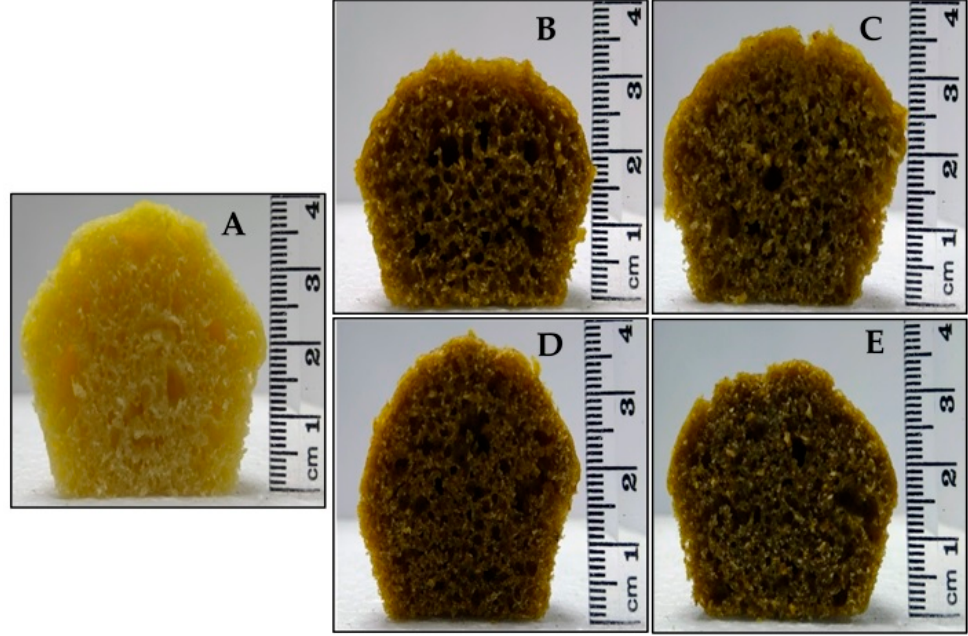
Figure 2. Muffin color and crumb structure images ( A ): control, ( B ): CAMa, ( C ): OAMa, ( D ): CAMe, ( E ): OAMa.